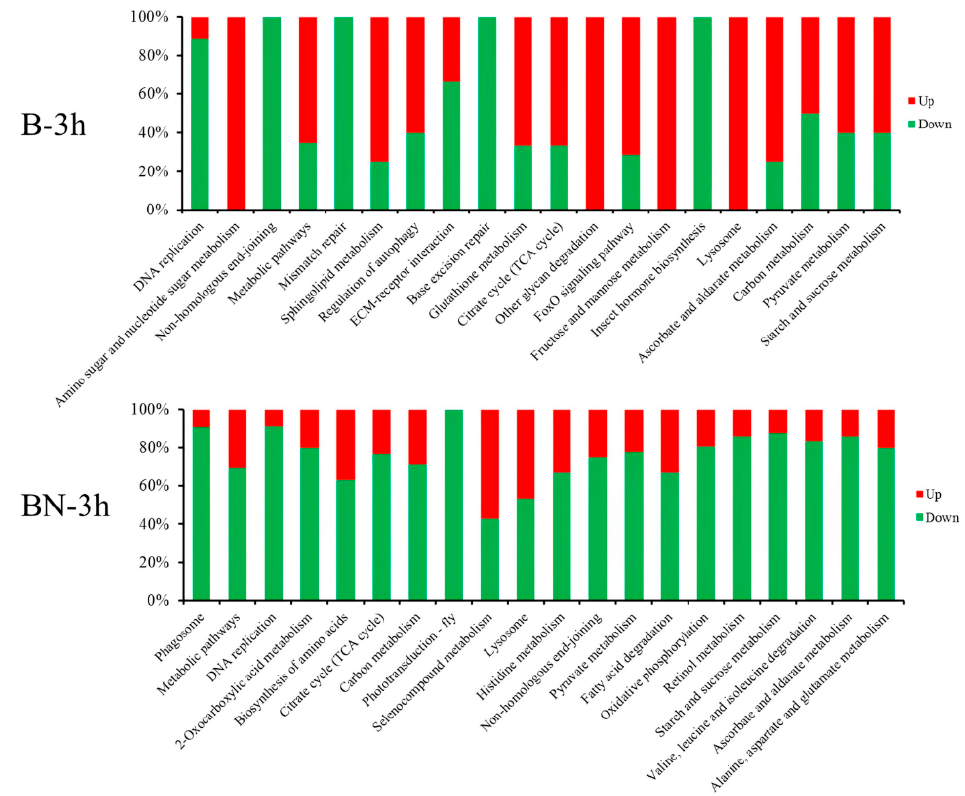
Figure 6. Percentage of up- or downregulated DEGs among different KEGG pathways in B-3h and BN-3h.